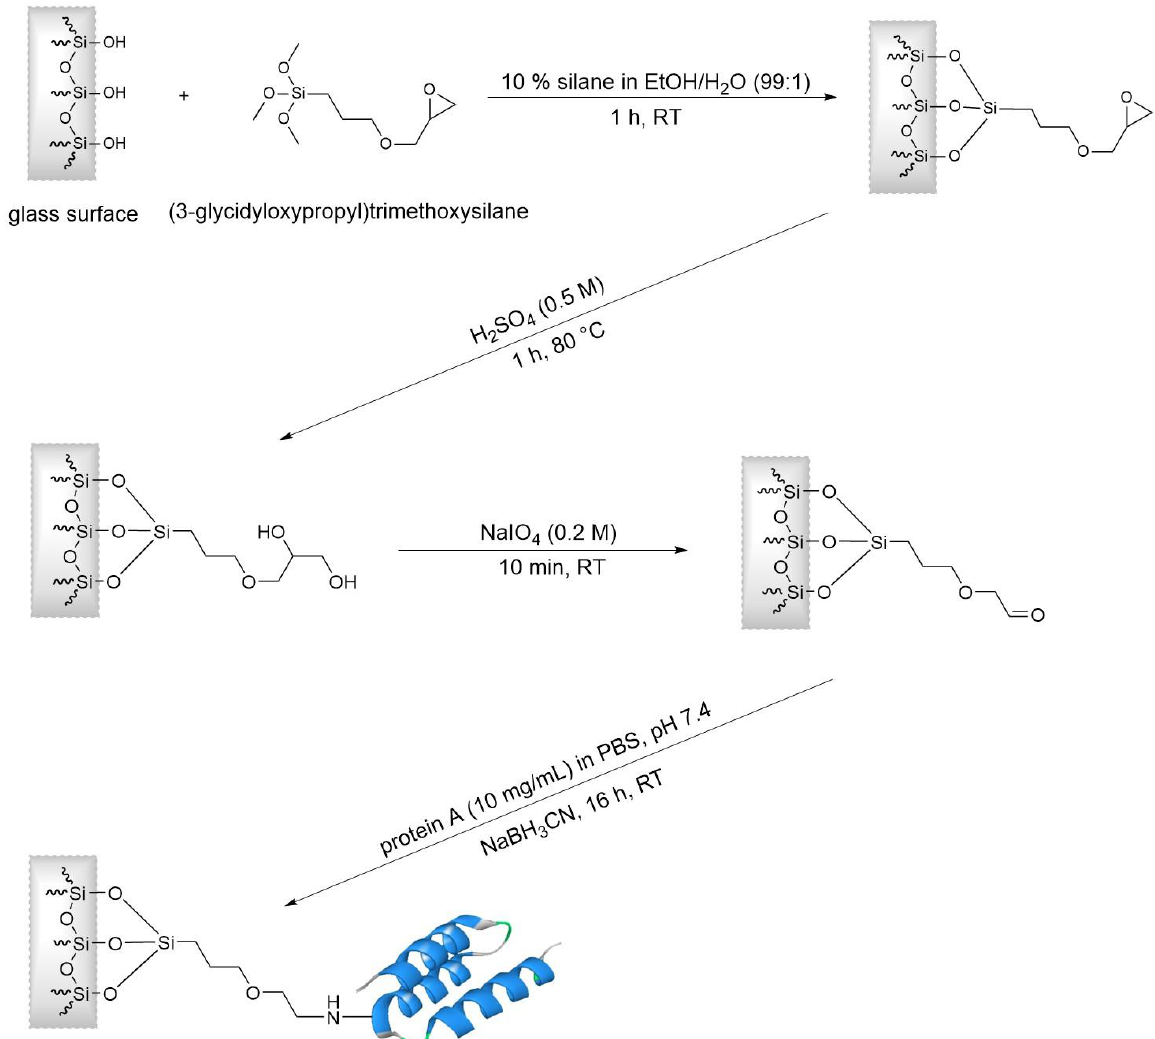
Figure 4. Scheme of the optimized column conjugation procedure: Surface functionalization with epoxysilane, hydrolysis with sulfuric acid, periodate oxidation, and conjugation of protein A via reductive amination.